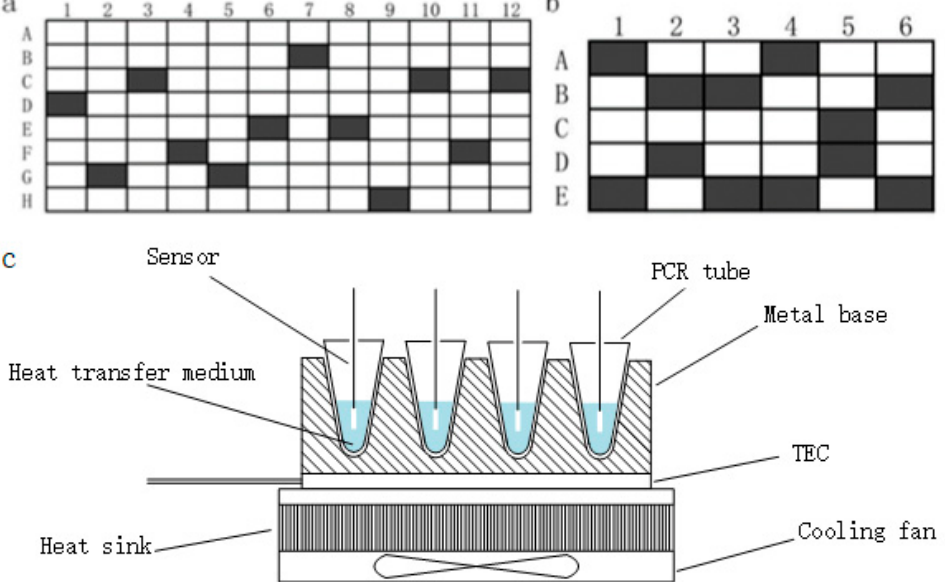
Figure 1. The temperature was measured in 0.2 mL PCR tubes at 12 random well positions. ( a ) The 12 well positions of the commercial PCR thermocycler were D1, G2, C3, F4, G5, E6, B7, E8, H9, C10, F11, and C12. ( b ) The 12 well positions of the homemade PCR thermocycler were A1, E1, B2, D2, B3, E3, A4, E4, C5, D5, B6, and E6. ( c ) Module structure diagram of self-made PCR temperature detection system.